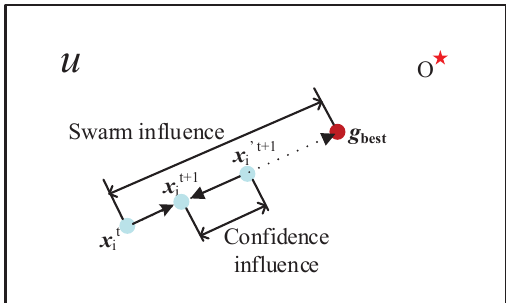
Figure 3. Optimization procedure of